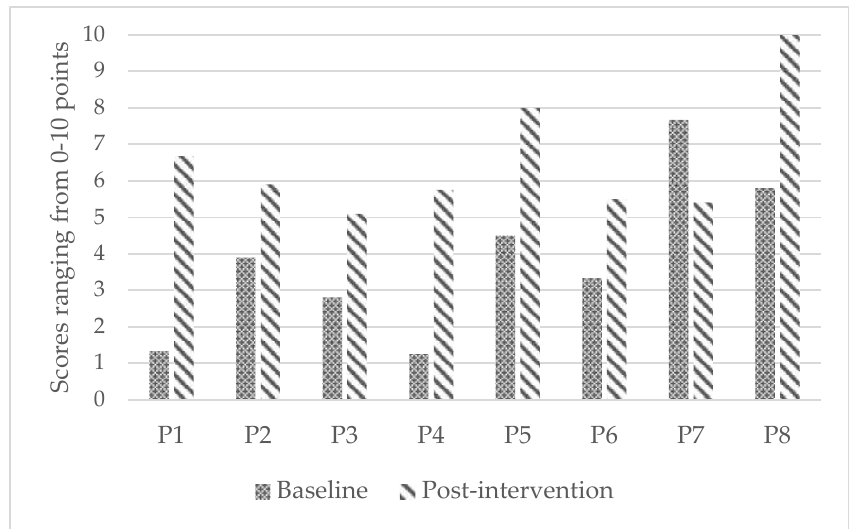
Figure 1. Individual improvements in satisfaction with participation from baseline to post-interven- tion.